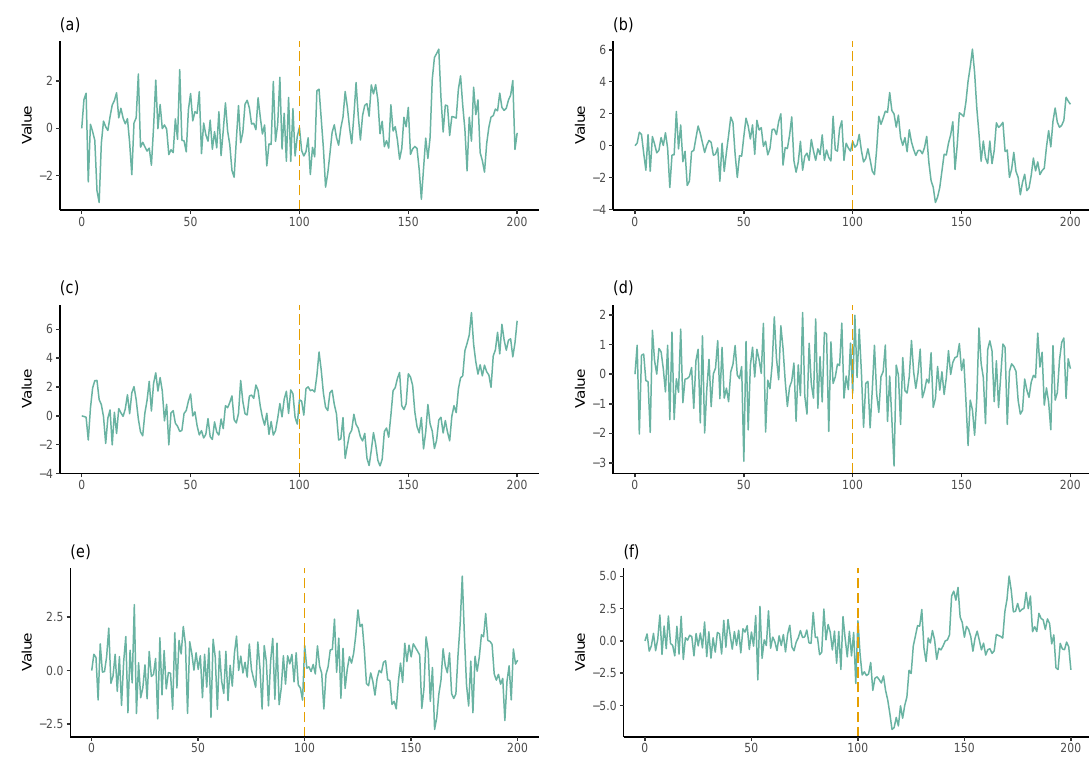
Figure 5. The figure describes the setting of scenario 2 in Example 2.2 by using one simulated AR(1) process. The plots display the autocorrelation coefficient variation: ( a ) from 0.1 to 0.5, ( b ) from 0.1 to 0.9, ( c ) from 0.5 to 0.9, ( d ) from − 0.5 to 0.1, ( e ) from − 0.5 to 0.5, and ( f ) from − 0.5 to